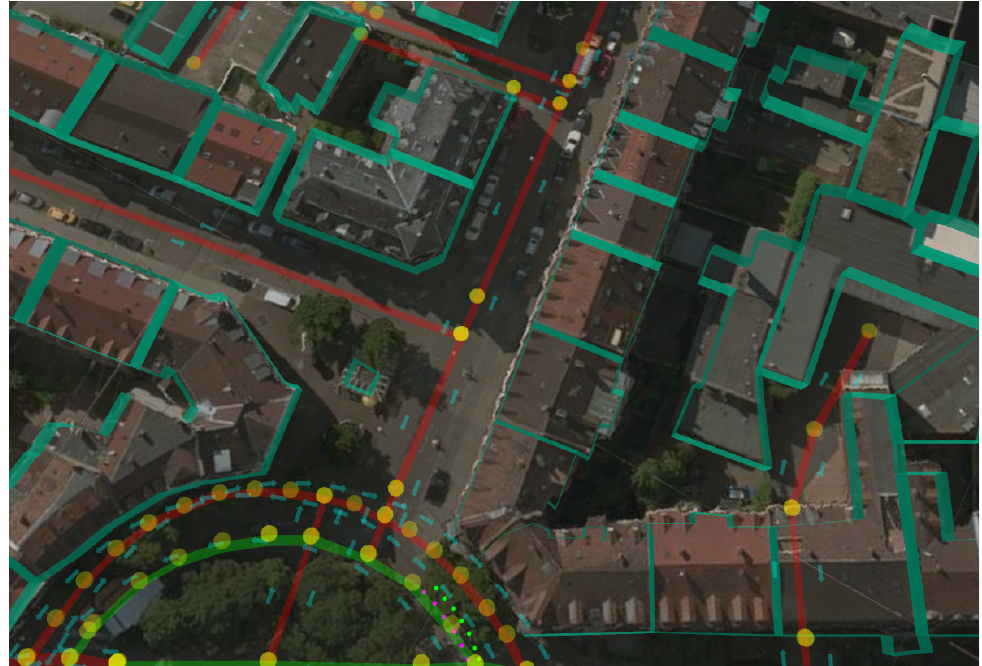
Figure 6. OpenStreetMap (OSM) with buildings’ outlines overlaid. The yellow dots represent the OSM nodes , the red lines the OSM ways and the light green rectangles the buildings